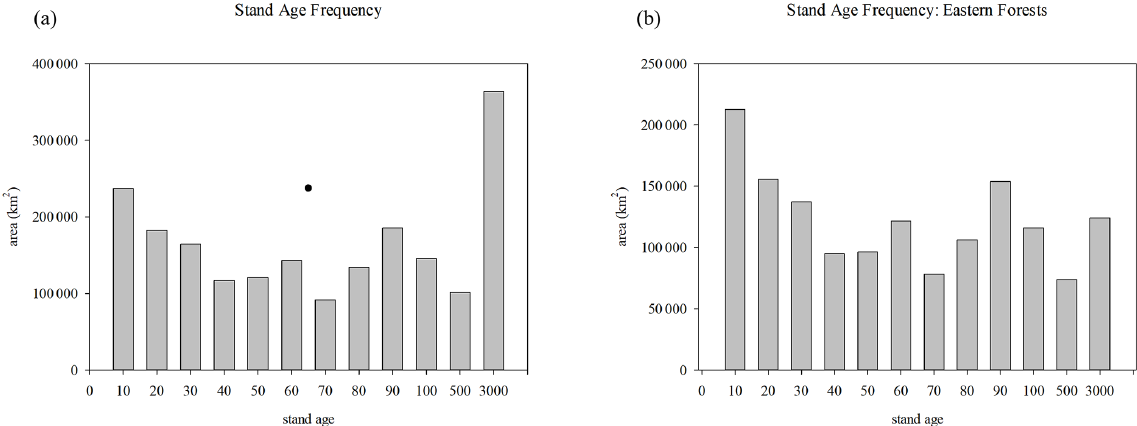
Figure 8. (a) Stand-age frequency for US and (b) eastern forests. Bins represent 0–10, 11–20, 21–30, 31–40, 41–50, 51–60, 61–70, 71–80, 81–90, 91–100, 101–500, > 500